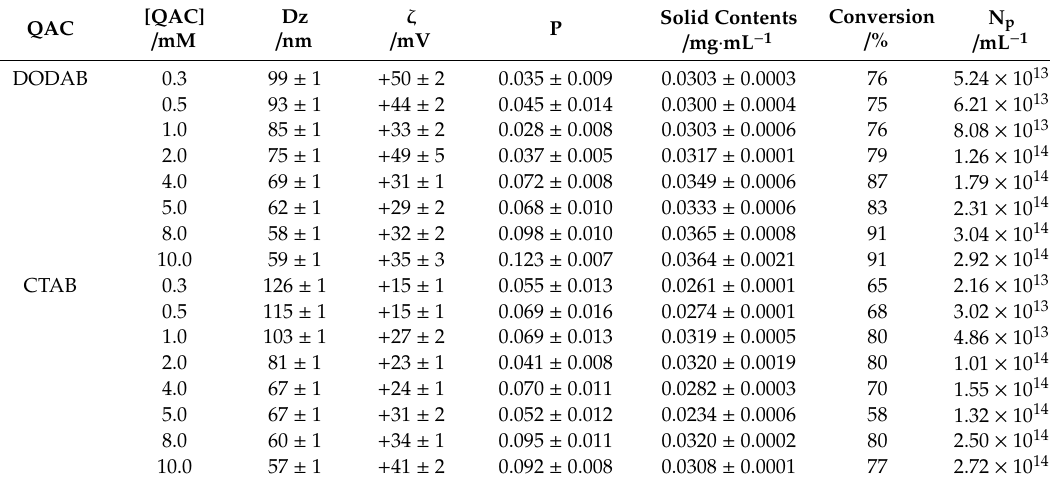
Table 3. Physical properties of PMMA / QAC NPs obtained by the emulsion polymerization of MMA monomer at 0.4 M MMA over a range of [QAC] using AIBN as the initiator. Zeta-average diameter (Dz), zeta potential ( ζ ), and polydispersity (P) were obtained by dynamic light scattering. The conversion of monomer into polymer was expressed in percentile. The particles number density (N p ), in mL − 1 , was calculated from nanoparticle size (Dz) and the mass of lyophilized dispersions.